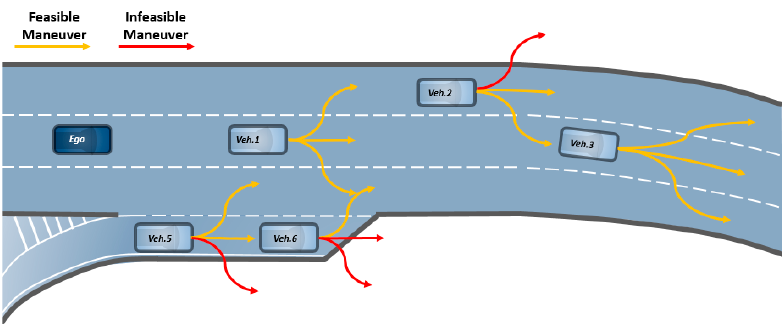
Figure 1. Schematic showing the concept of road-aware trajectory prediction: vehicles should run along roadway while obeying the structural constraints of the road.